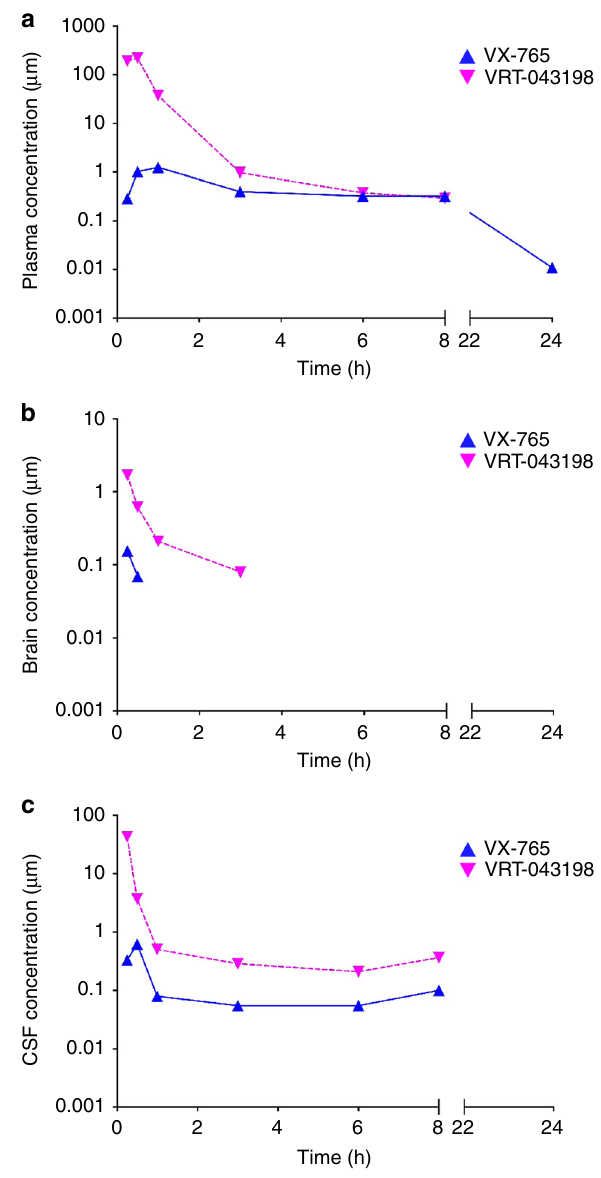
Fig. 1 VX-765 and VRT-043198 are detected in mice after a single dose of VX-765. a – c PK measures of VX-765 and active VRT-043198 metabolite in a plasma, b whole brain homogenates, and c CSF samples up to 24 h after a single IP injection of 50 mg · kg − 1 VX-765 ( n = 2 mice per time